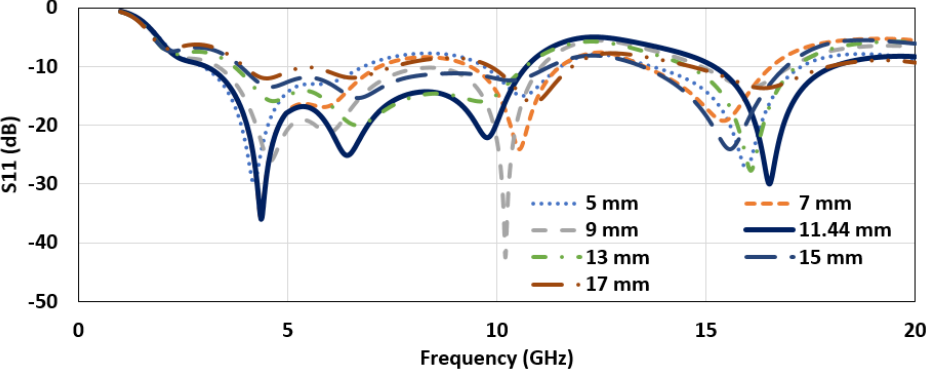
Figure 3. The reflection coefficient plot for different values of cut length of the feedline (depth, C x = 0.2 mm).